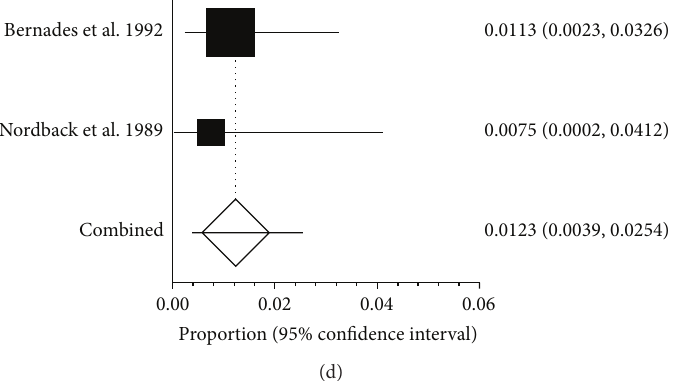
Figure 5: (a) Forest plots showing the prevalence of splanchnic vein thrombosis (SVT) in chronic pancreatitis (CP). (b) Forest plots showing theprevalenceofportalveinthrombosis(PVT)inchronicpancreatitis(CP).(c)Forestplotsshowingtheprevalenceofsplenicveinthrombosis (SlpVT) in chronic pancreatitis (CP). (d) Forest plots showing the prevalence of mesenteric vein thrombosis (MVT) in chronic pancreatitis